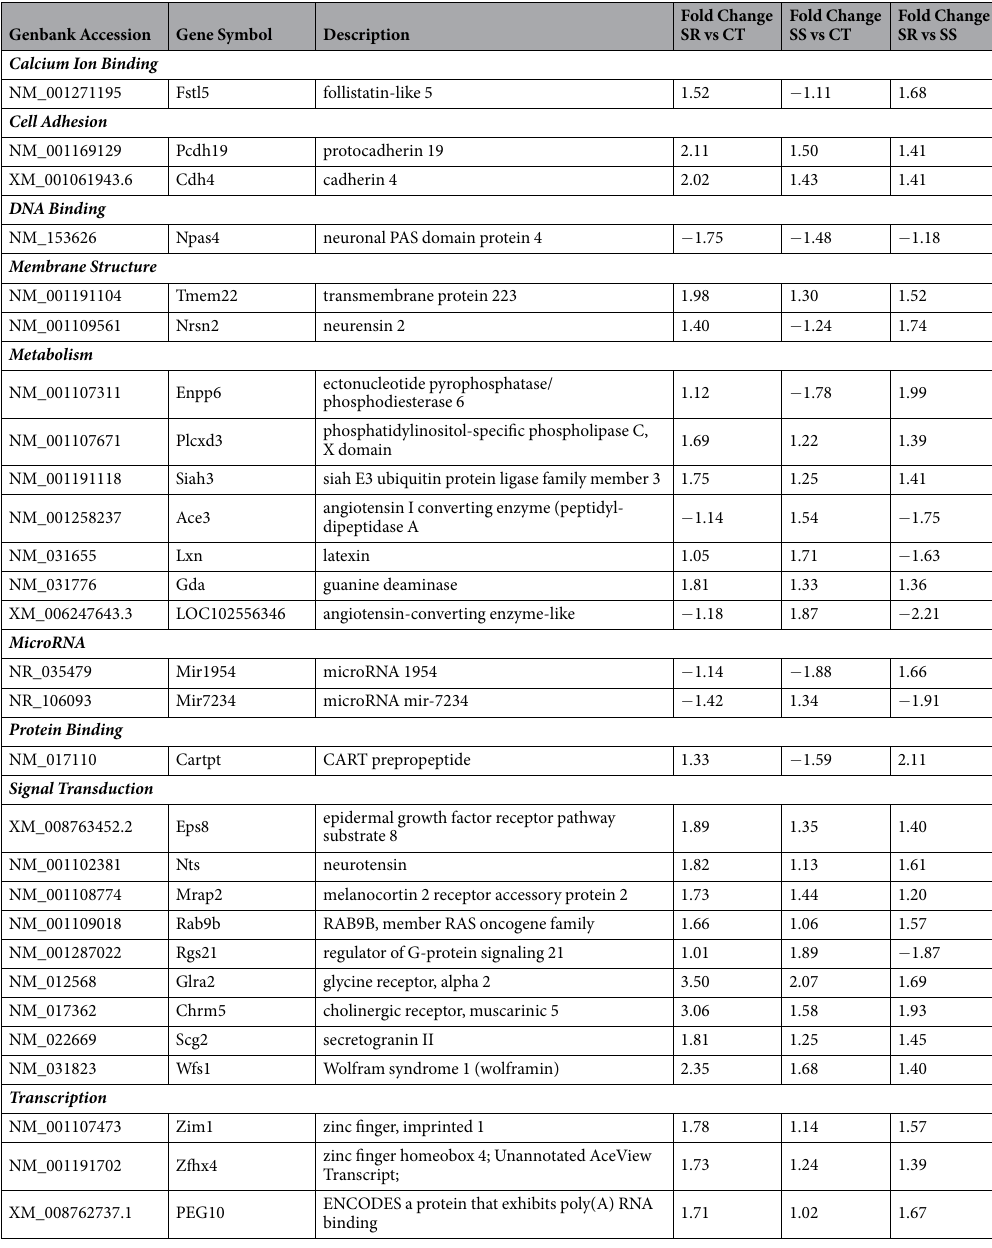
Table 2. Classification of striatal genes with differential expression after METH SA and